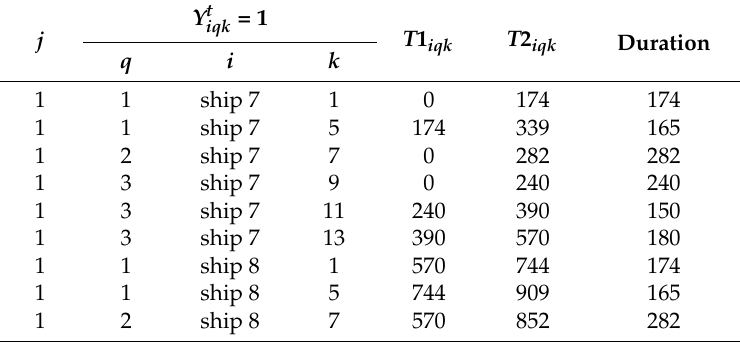
Table 1. The total solution to BAP, QCAP, and